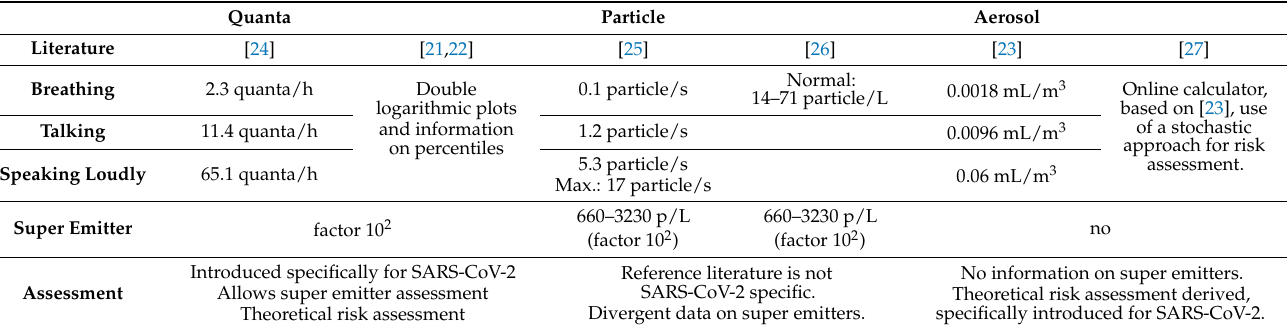
Table 1. Comparison of the source description of the